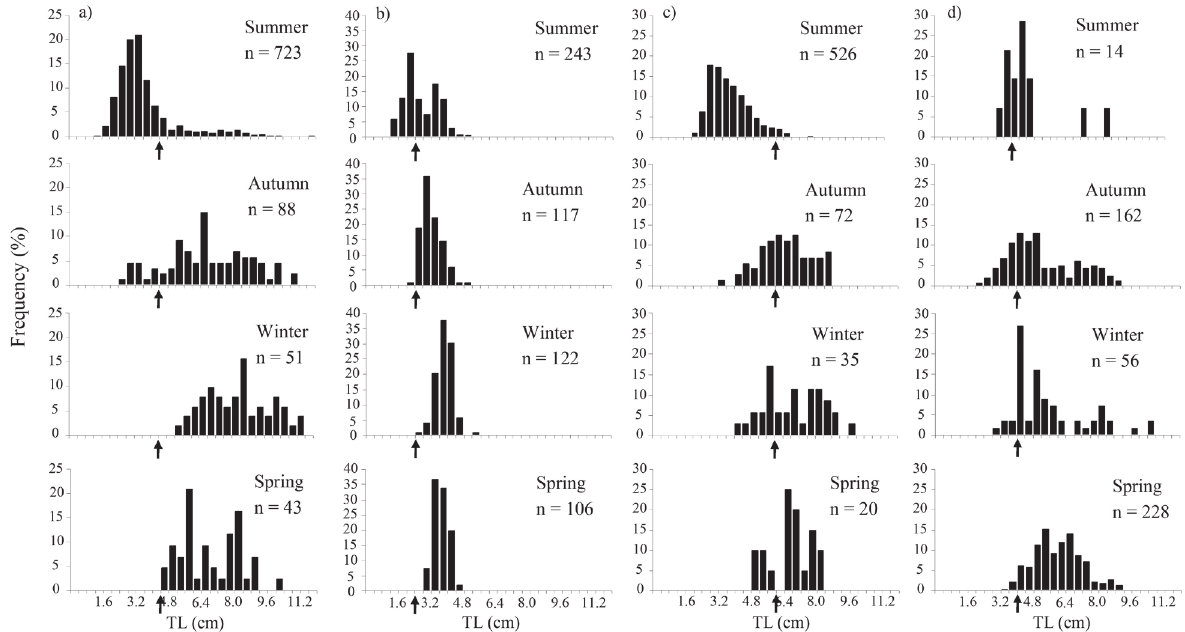
Fig . 4. − Size frequency distributions of the studied species within season: a) Salaria pavo , b) Pomatoschistus marmoratus , c) Gobius cobitis , d) Gobius niger . Arrows indicate the typical body size at maturity of each species.